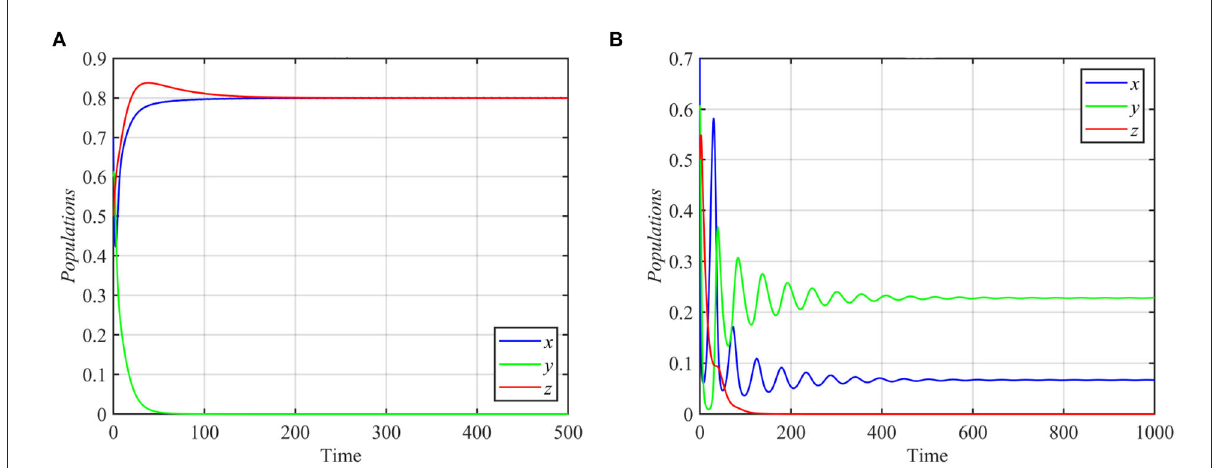
FIGURE2 Trajectories of system (1) for different values of r , with other parameters as in equation (17). (A) Time series for trajectories of x , y , and z for r which approach E 2 (0.8,0,0.8). (B) Time series for trajectories of x , y , and z for r =